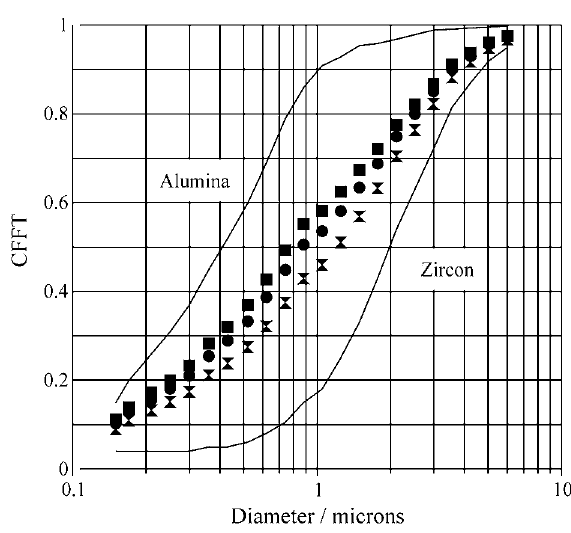
Figure 1. Cumulative fraction finer than diameter CFFT vs. particle diameter D curves of alumina and zircon mixtures: • stoichiometric, with a 6 wt% excess of alumina and x with a 10 wt% excess of